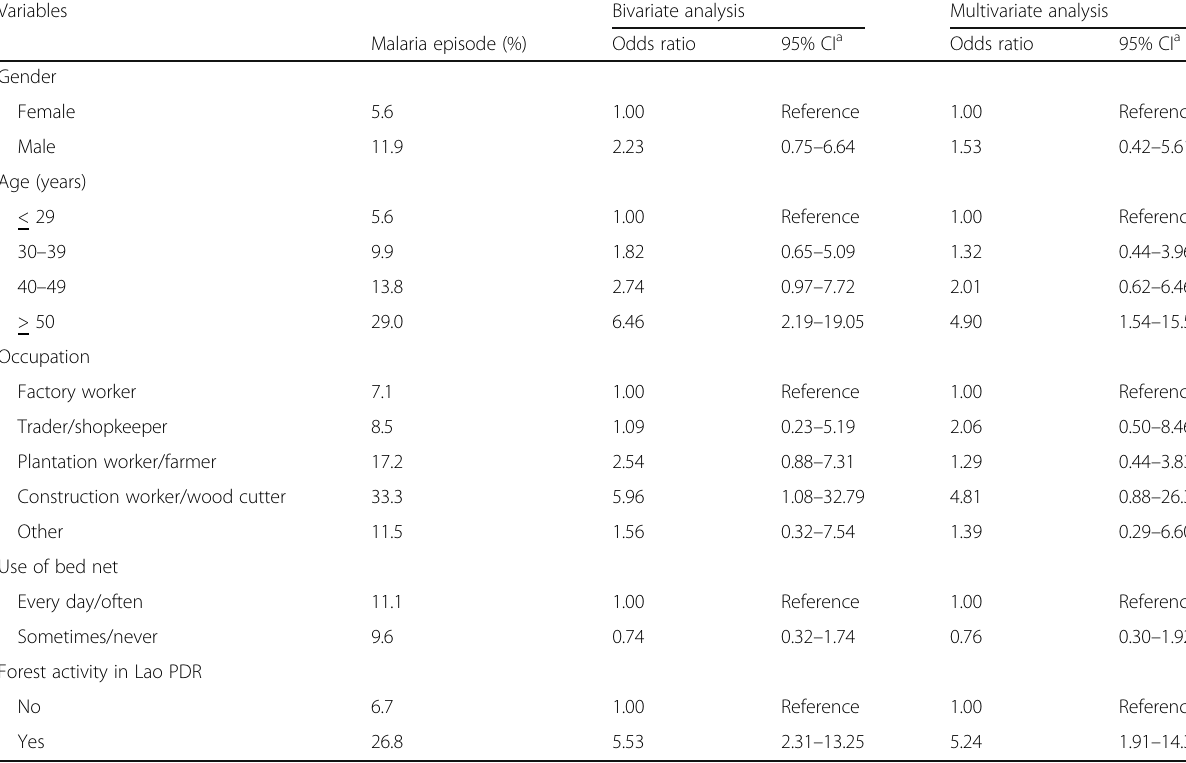
Table 6 Factors associated with malaria episodes that occurred in Lao PDR among the study participants ( n = 308)